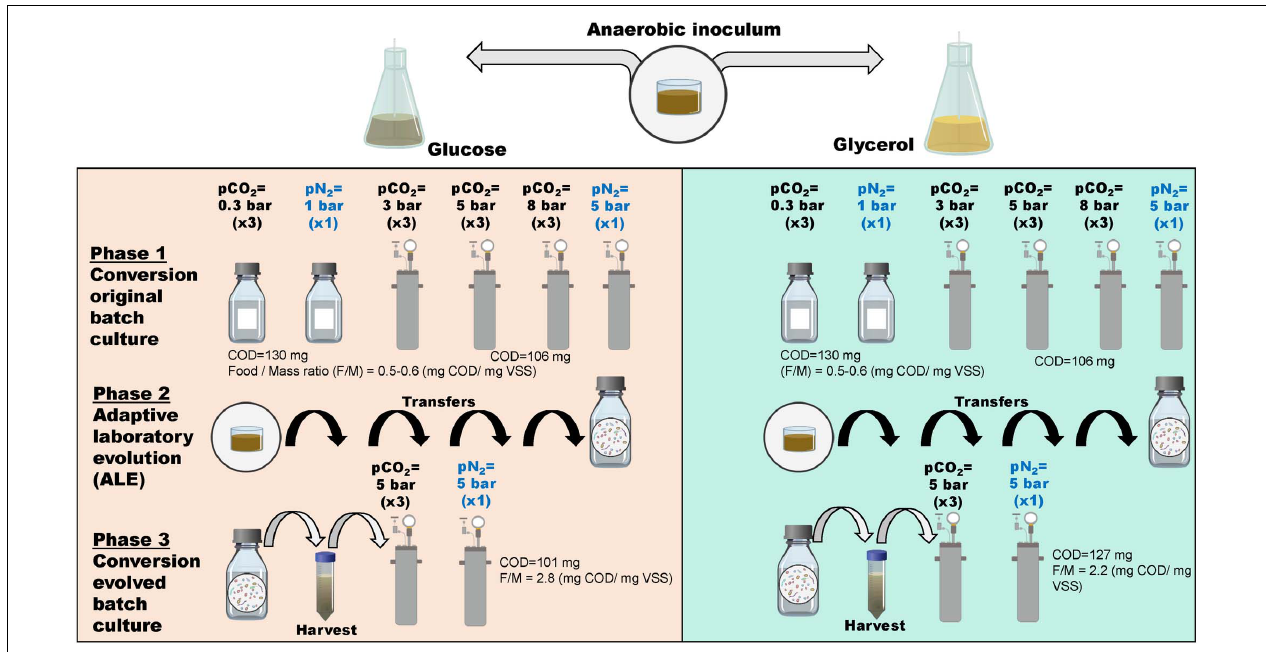
FIGURE 1 | Graphical summary of experimental conditions for the anaerobic conversion experiments at elevated pCO 2 using glucose and glycerol as substrates. Experiments are organized according to substrate and inoculum